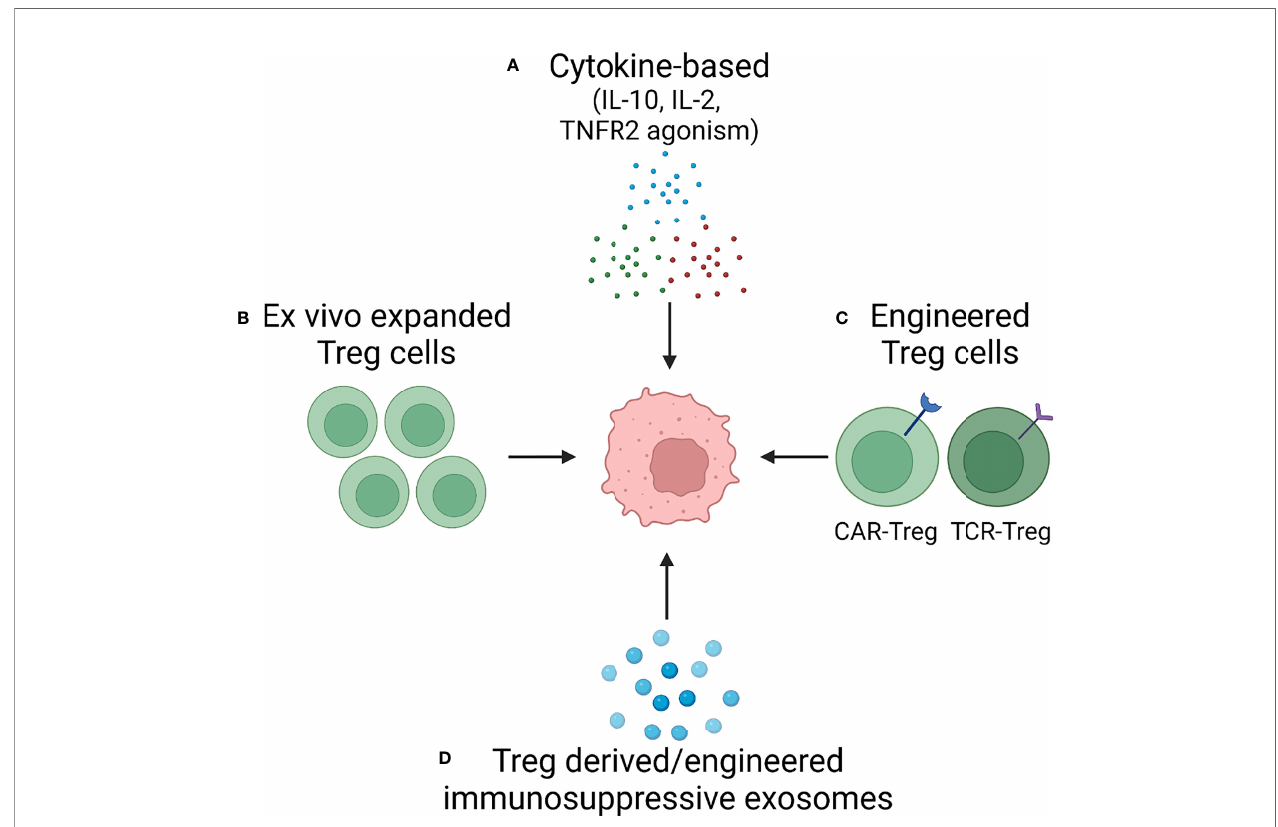
FIGURE 4 | Treg cells as Therapeutic Tools – Approaches in Development. Based on increasing understanding of Treg cell biology, several approaches are in development to harness the immunosuppressive capabilities of Treg cells. Current attempts to develop versatile, effective and functionally competent cells and reagents that can be applied as immunomodulatory treatments in autoimmune disease fall into four categories: (A) Cytokine-based therapy applying suppressive cytokines (e.g., IL-10) or providing growth factors for Treg expansion (IL-2). (B) Ex vivo expansion of Treg cells. (C) Engineering of highly competent, antigen-speci fi c or chimeric antigen receptor Treg cells. (D) Exploitation of exosomes, small membrane vesicles derived from multivesicular bodies and released at the plasma membrane. Treg cells package a diverse cargo into exosomes to communicate with their cellular neighbors and such exosomes can be generated as cell-free reagents for precise delivery of information to other immune cells and to tissue